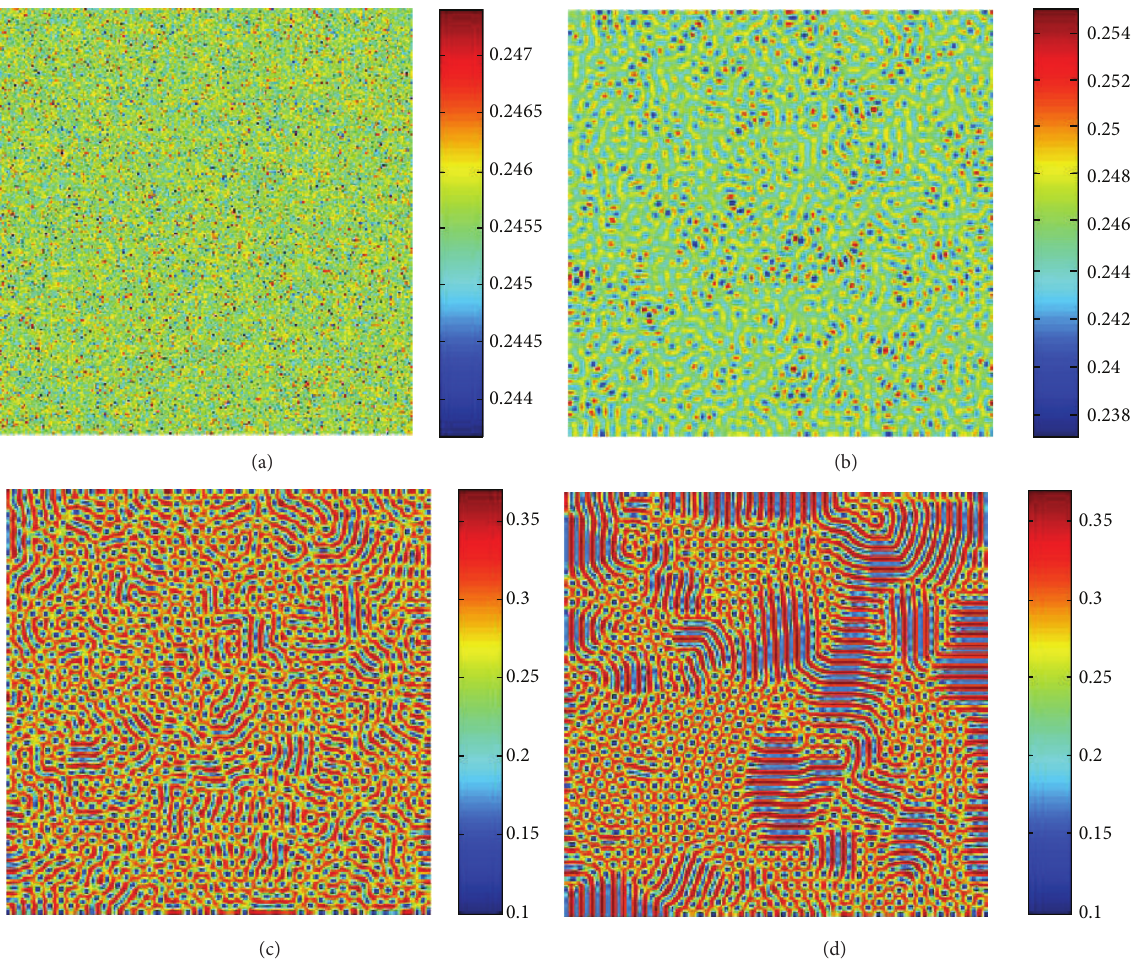
Figure 3: Snapshots of the time evolution of the prey at different instants with 𝛾 = 1 , 𝑑 = 0.08 , 𝑠 = 1.31 , 𝜏 = 0.2 , 𝐷 𝑢 = 0.1 , and 𝐷 V = 3.68 , which are in the Turing space. (a) 0 iteration; (b) 10000 iterations; (c) 50000 iterations; and (d) 300000